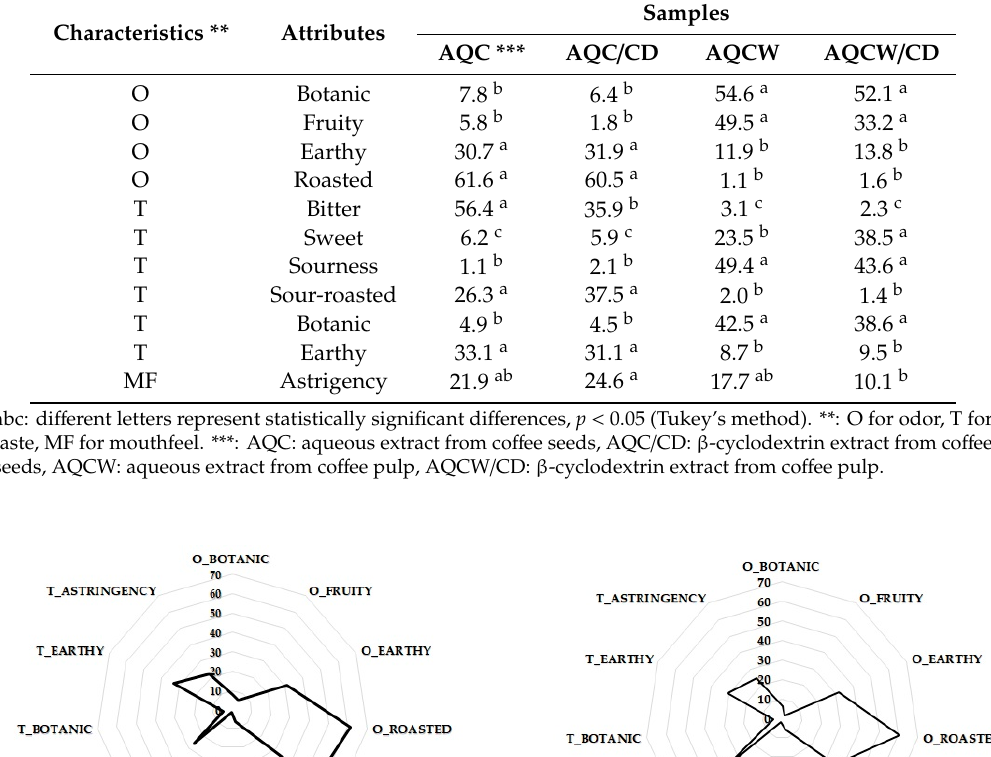
Table 5. Mean intensity scores of aroma and taste attributes for the di ff erent brews. Characteristics **